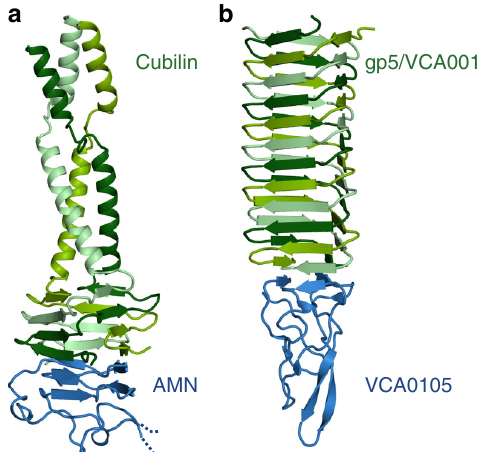
Fig. 7 Comparison of the AMN – cubilin complex with the V. cholerae spike protein VCA0018/VCA0105. a Cartoon representation of AMN β -helix 1 (blue) in complex cubilin (residues 36 – 135, shades of green). b Cartoon representation of V. cholerae VCA0105 (blue) in complex with the gp5/ VCA0018 fusion protein (shades of